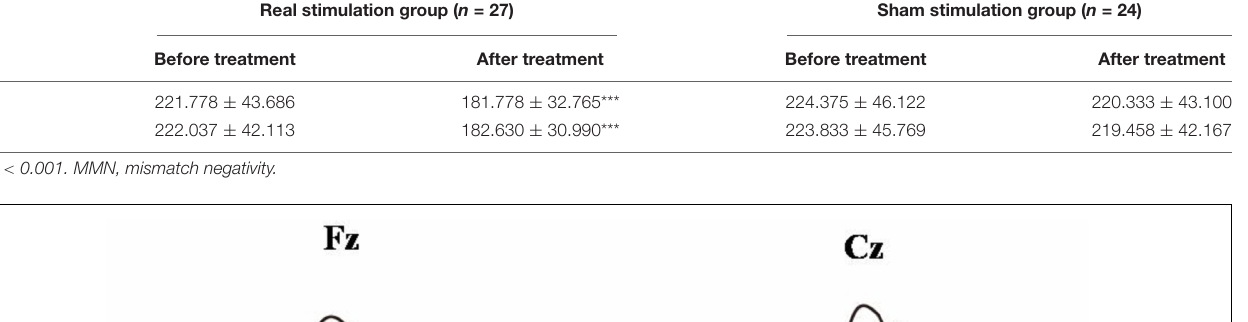
TABLE 3 | Comparison of MMN latency between the two groups before and after treatment ( ¯ x ± s). Real stimulation group ( n = 27)